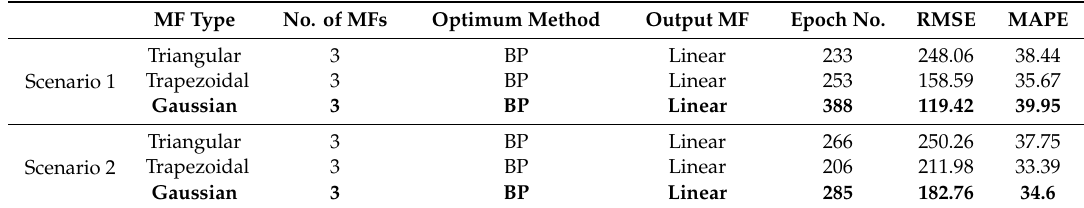
Table 3. ANFIS training results